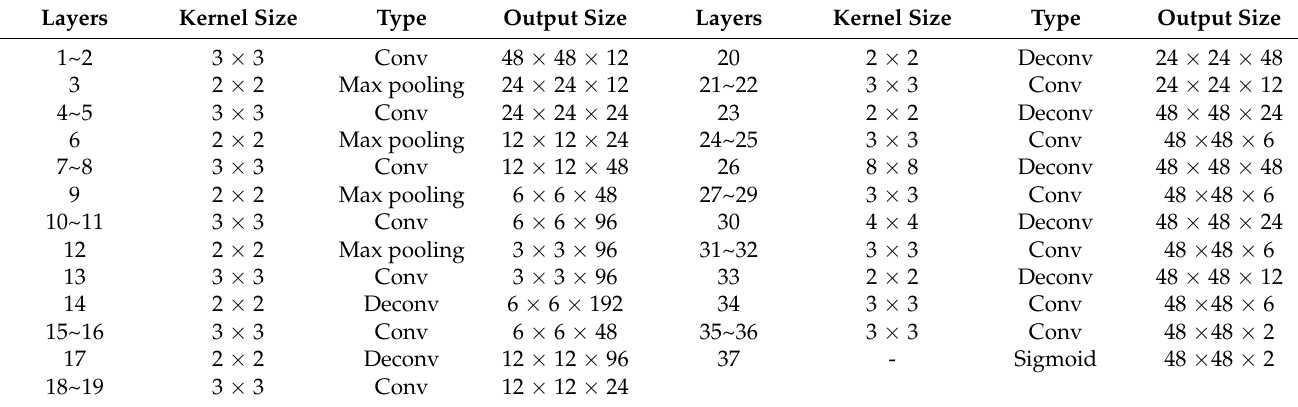
Table 1. Details of the